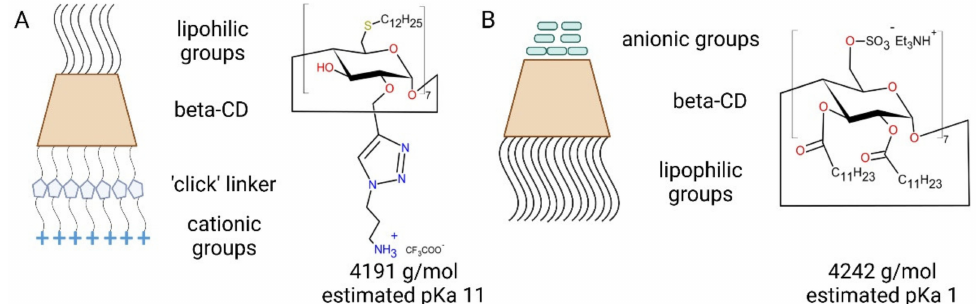
Figure 2. Chemical structure (mol. MW and pK a ) and schematic of charged amphiphilic cyclodextrins (CDs). ( A ) The amphiphilic cationic CD, with lipid chains (SC 12 ) on the primary side and a primary amine function on the secondary side. ( B ) The amphiphilic anionic CD, with a negative functional group on the primary side and lipid chains (SC 12 ) on the secondary